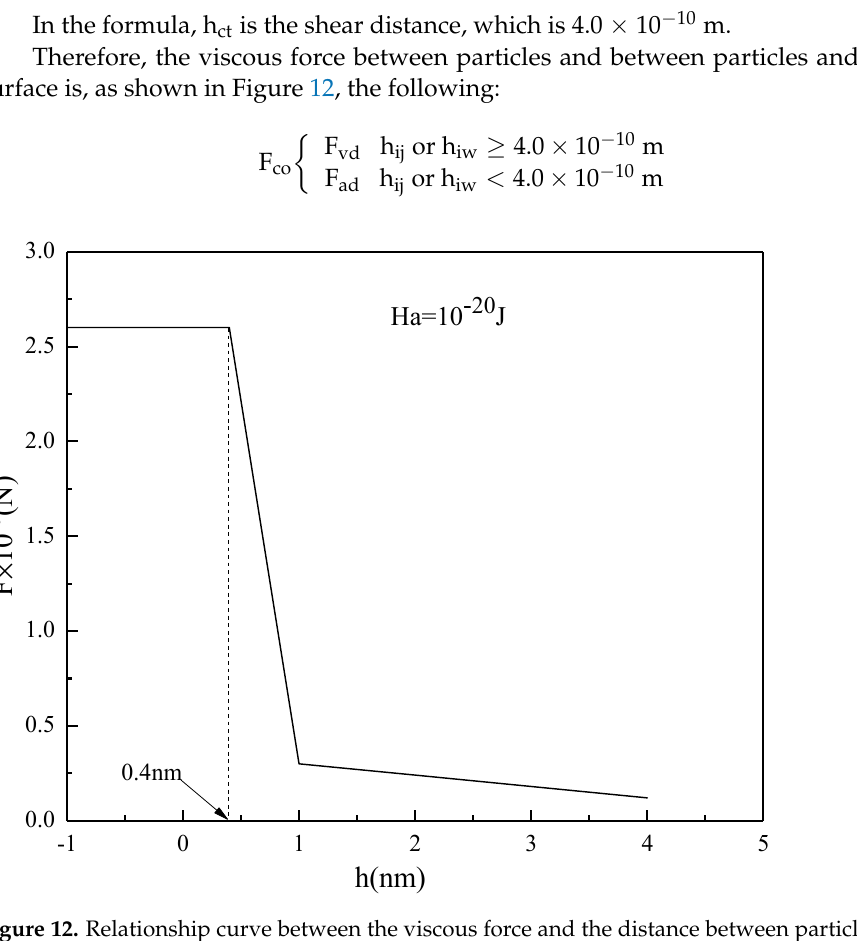
Figure 12. Relationship curve between the viscous force and the distance between particles.